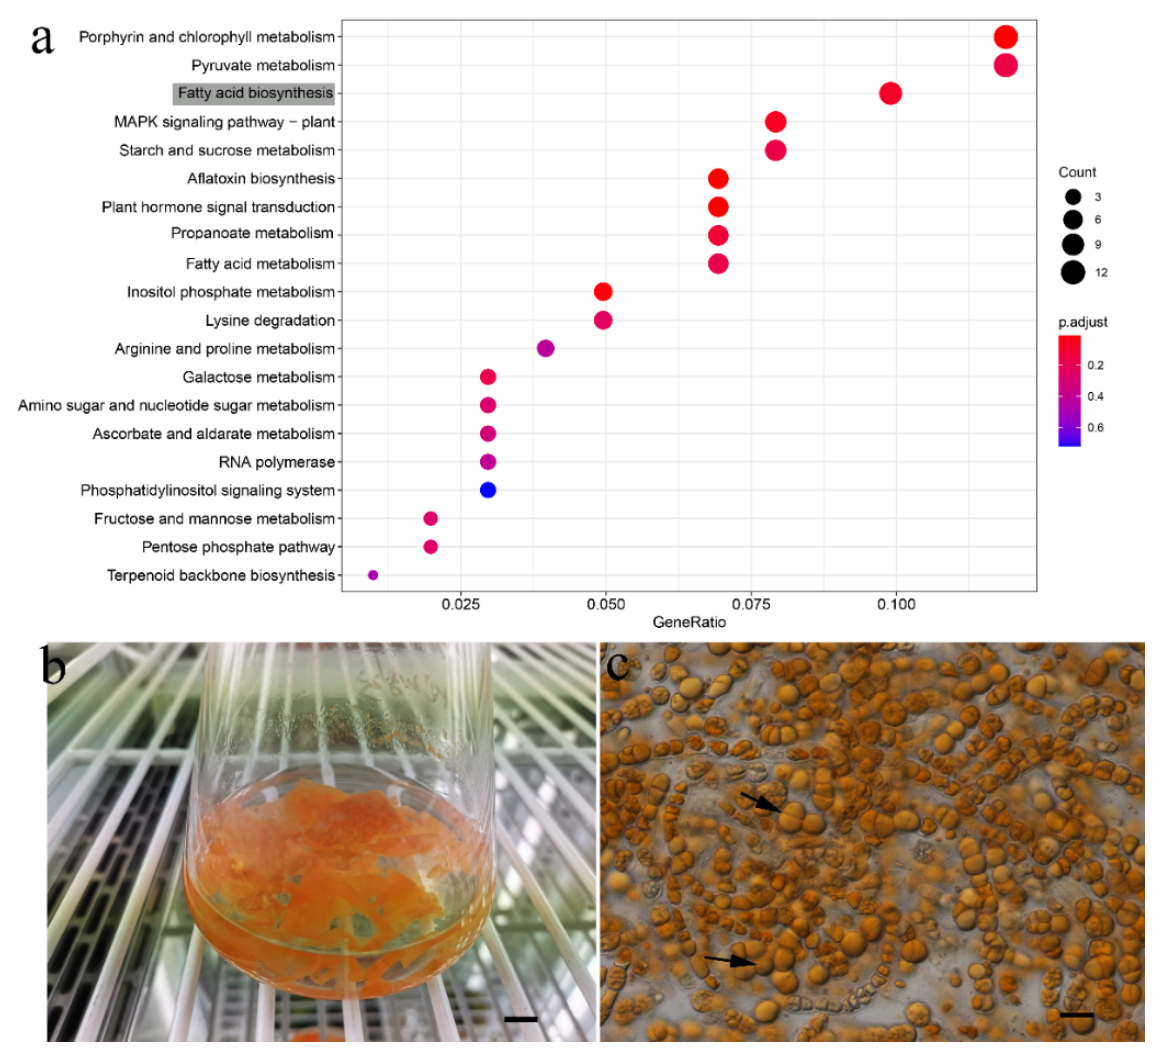
Figure 3. ( a ). Dot plot displaying the enrichment of F. tuberosa ’s expanded gene families. The numbers of genes were represented by dot sizes. Fatty acid biosynthesis was in grey. ( b ) Shows the color change of the F. tuberosa in culture. ( c ) The arrow indicates the fatty acid. Scale bars: b = 1 cm; c = 20 μ m.